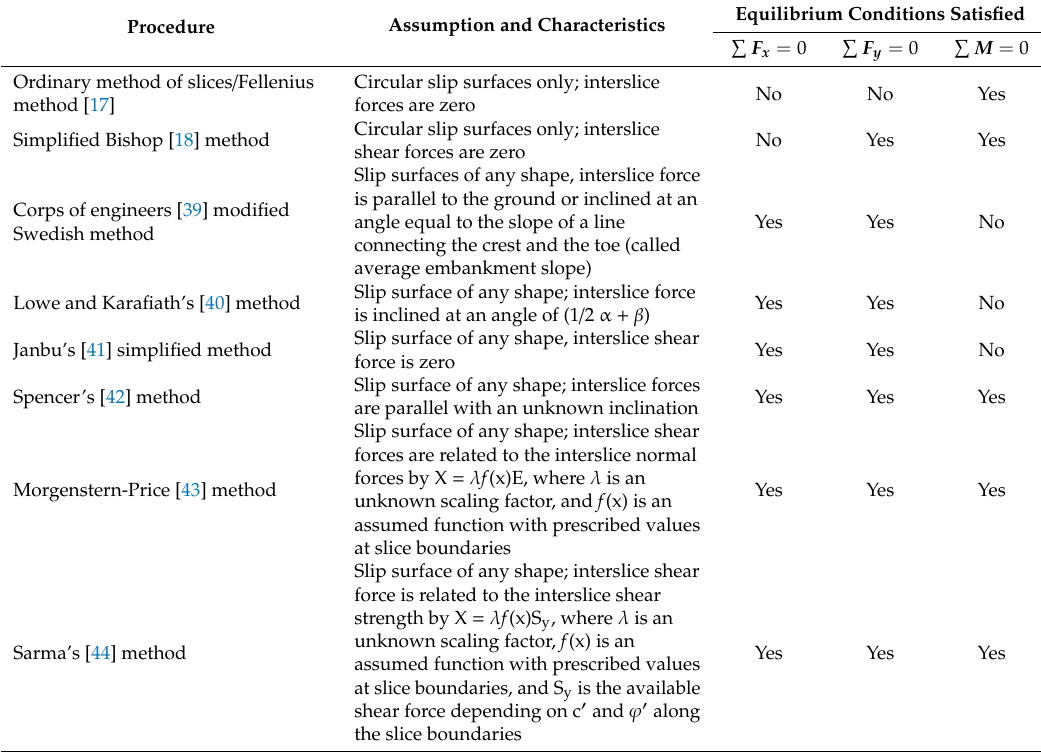
Table 3. Commonly used slope stability analysis methods and their assumptions (modified from Sivakugan & Das